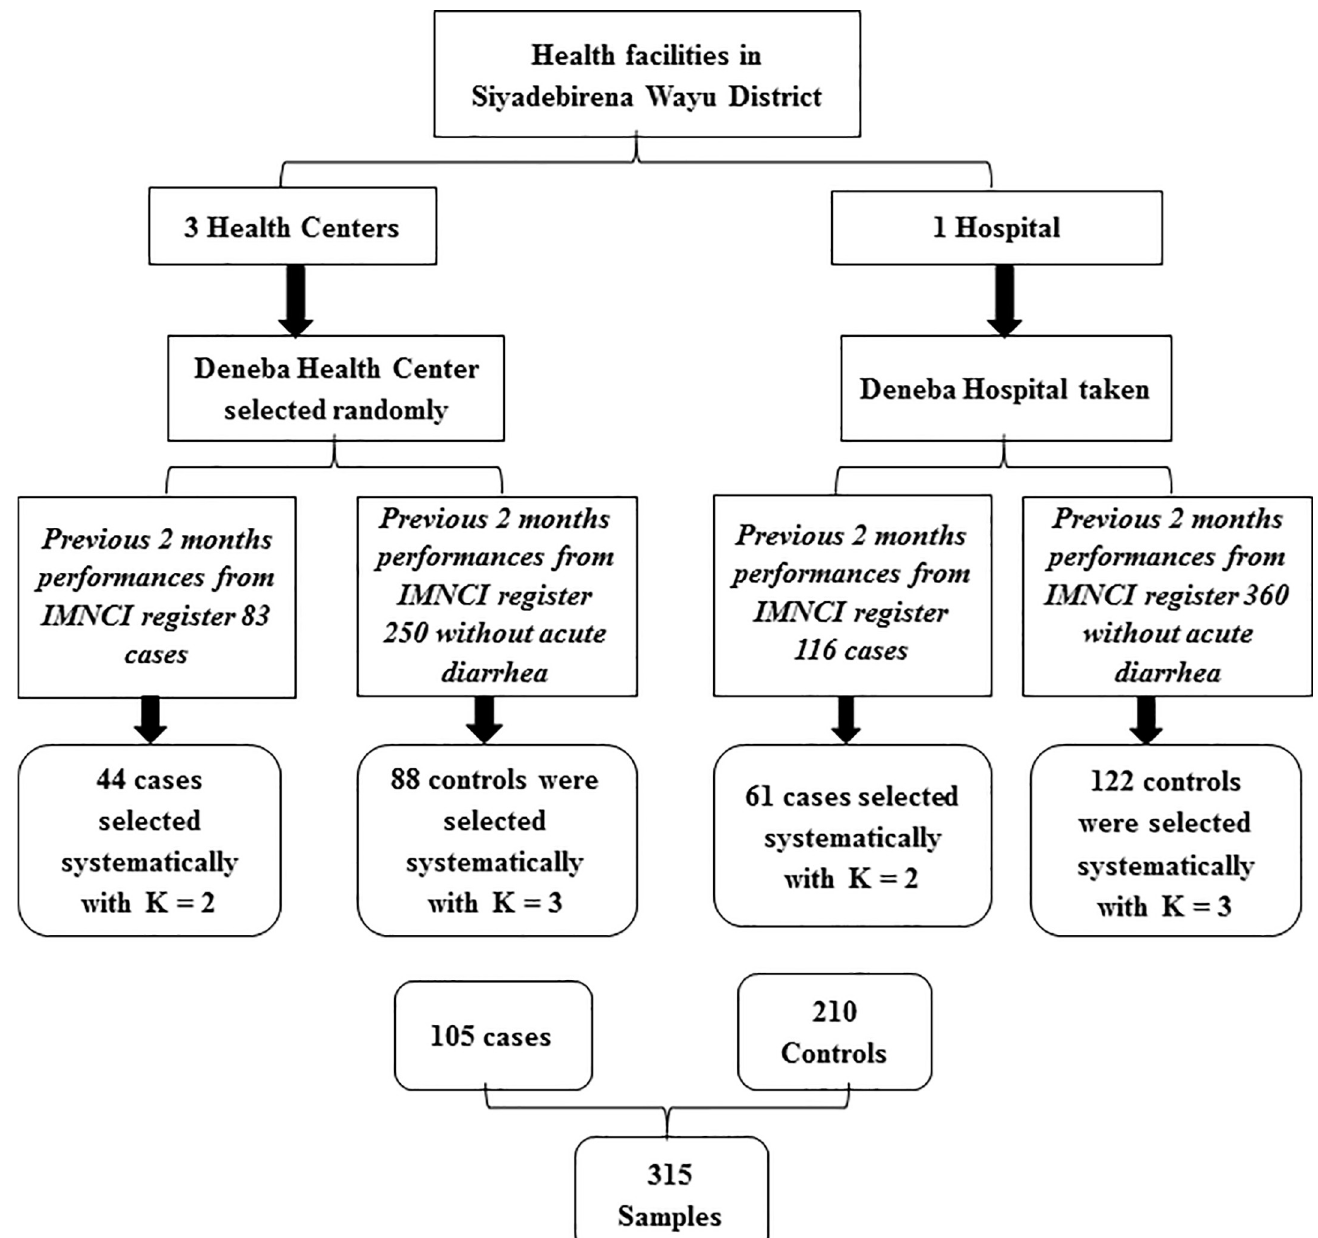
Fig 1. Sampling procedures for cases and controls in Siyadebirena Wayu district, North Shoa Zone, Amhara region, Ethiopia, 2019.